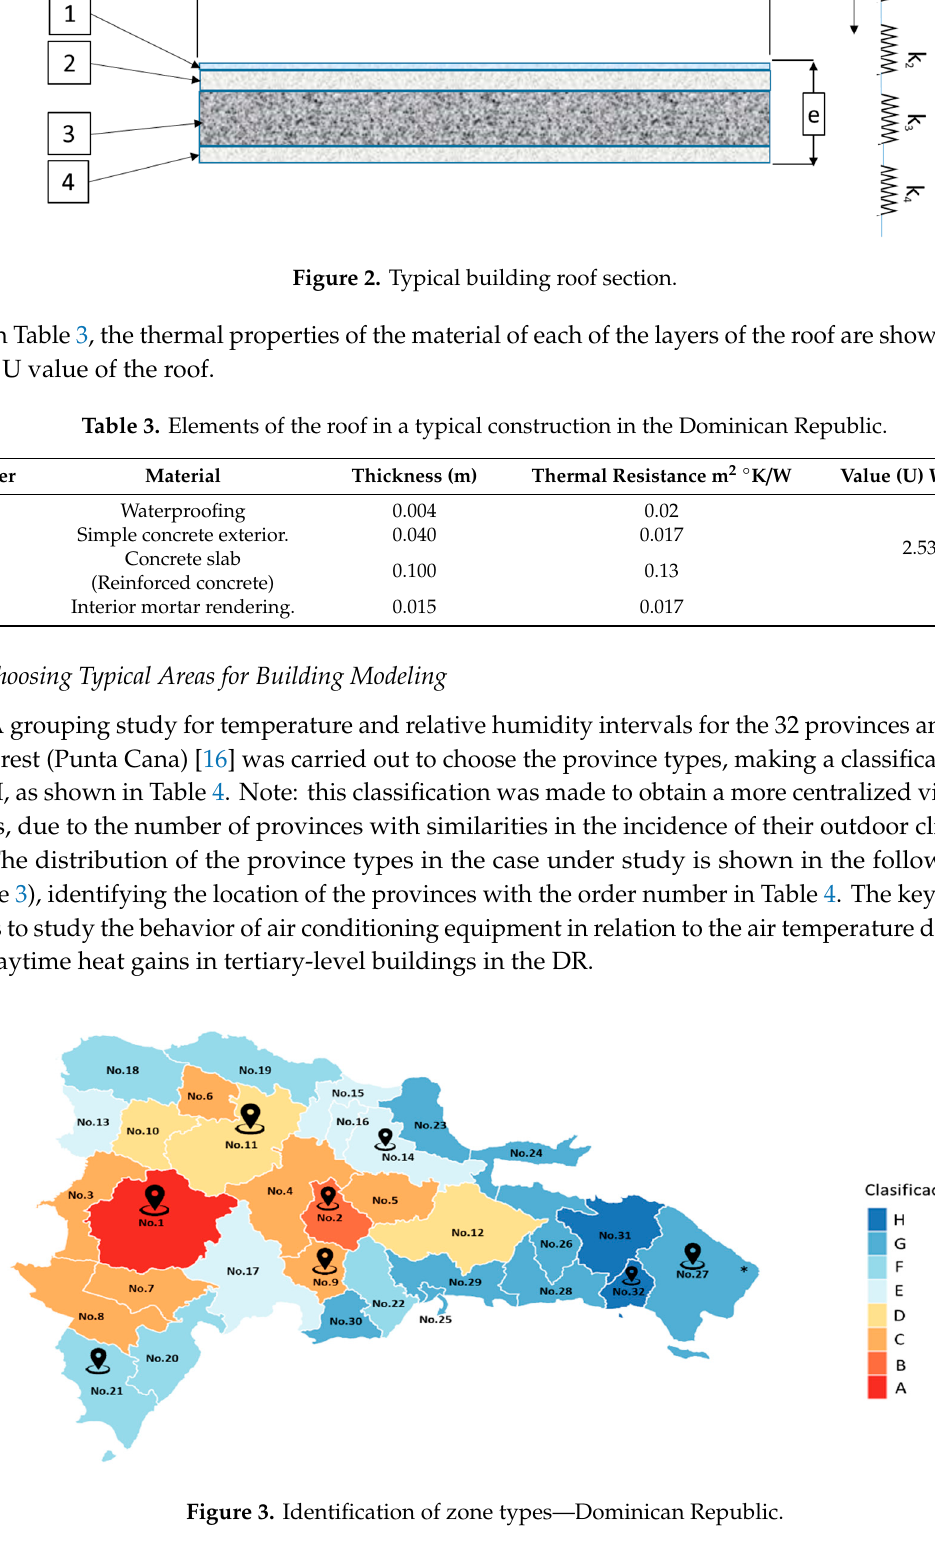
Figure 4. View of building types for each area of the case under study. These buildings are located in the areas marked on the map (Figure 3) and represent the range of building typologies and climatic conditions that impact the said typology in each area. 2.4. Calculation of the Total Thermal Power of Building Types